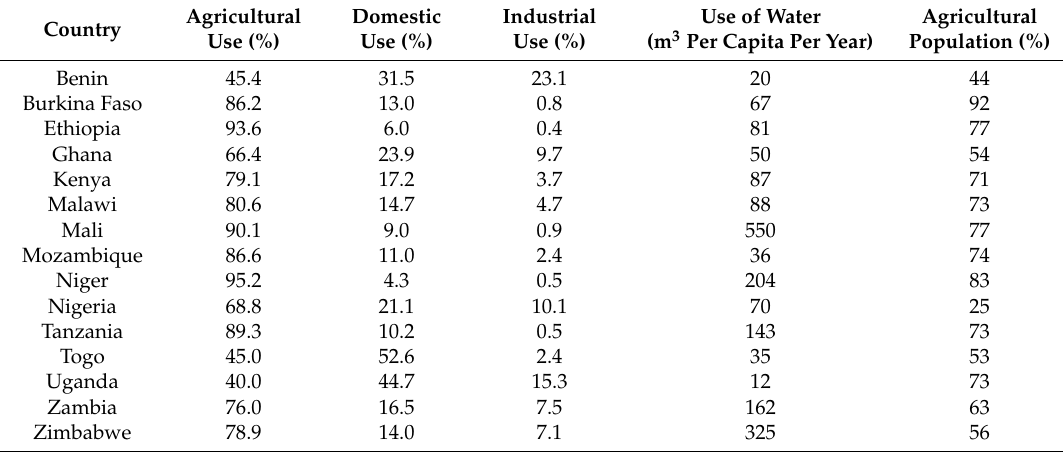
Table 2. Distribution of water resources withdrawal (percentage) from surface water and groundwater reserves in the 15 selected countries for three major water-consuming sectors: agriculture, domestic, and industrial; and the agricultural population as a percentage of the total population (FAO)